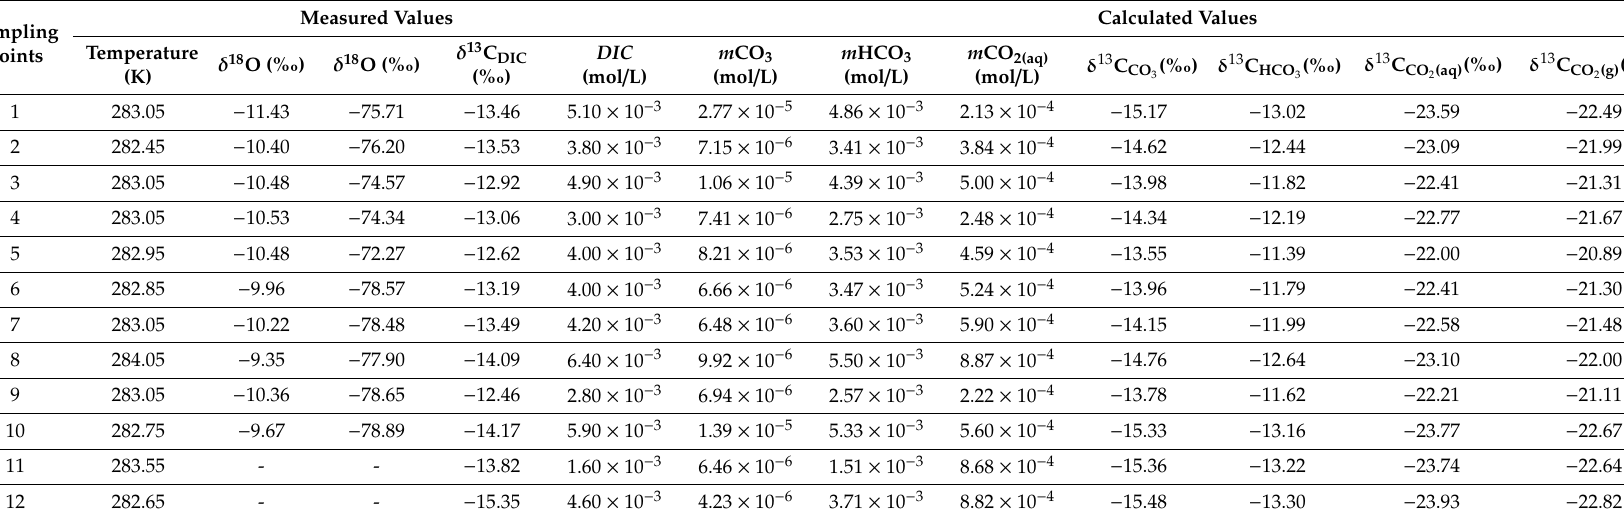
Table 2. Determinations of stable isotopes of oxygen and carbon in groundwater with calculations of chemical and isotope equilibrium with regard to the main speciations of carbon